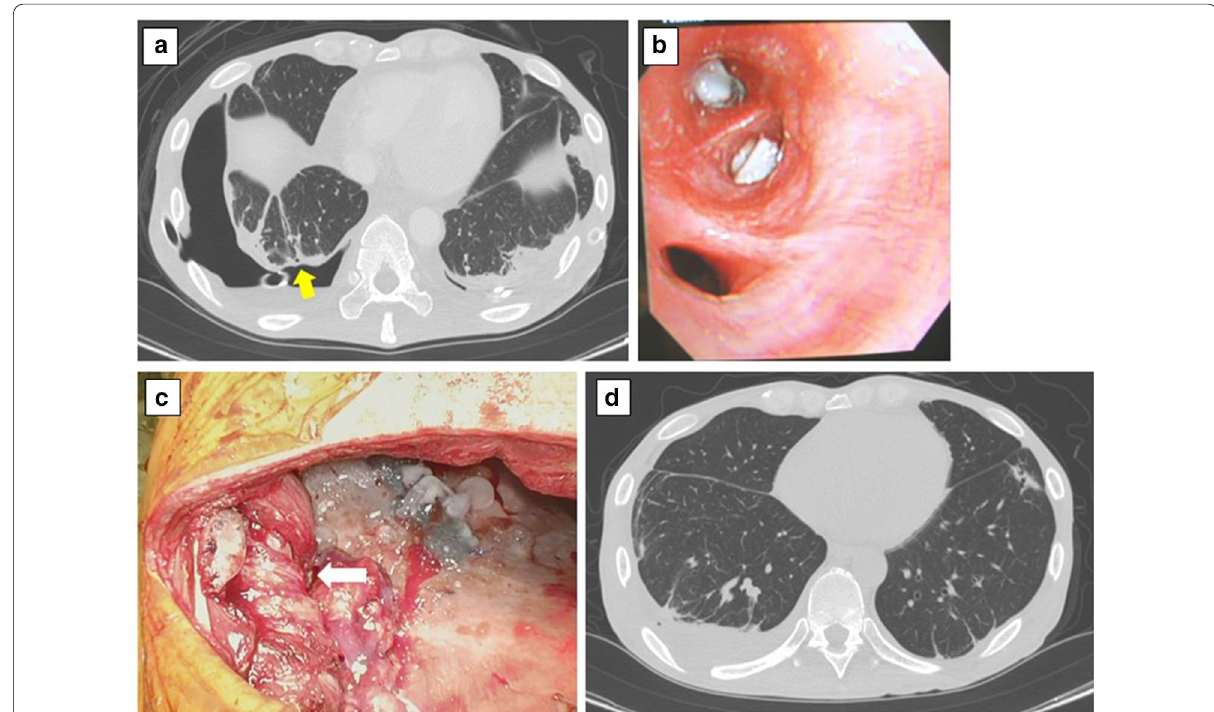
Fig. 2 a CT after the first operation revealed a bronchopleural fistula in the right pleural cavity. The right B 10 c was thought to be the responsible bronchus (yellow arrow). b Endobronchial Watanabe spigots were inserted into the right B 10 b and B 10 c bronchi. c The right S 10 fistula was superimposed and closed using a pedicled intercostal muscle flap (white arrow). d CT after the second operation showed that both sides of the lung expanded without residual pleural